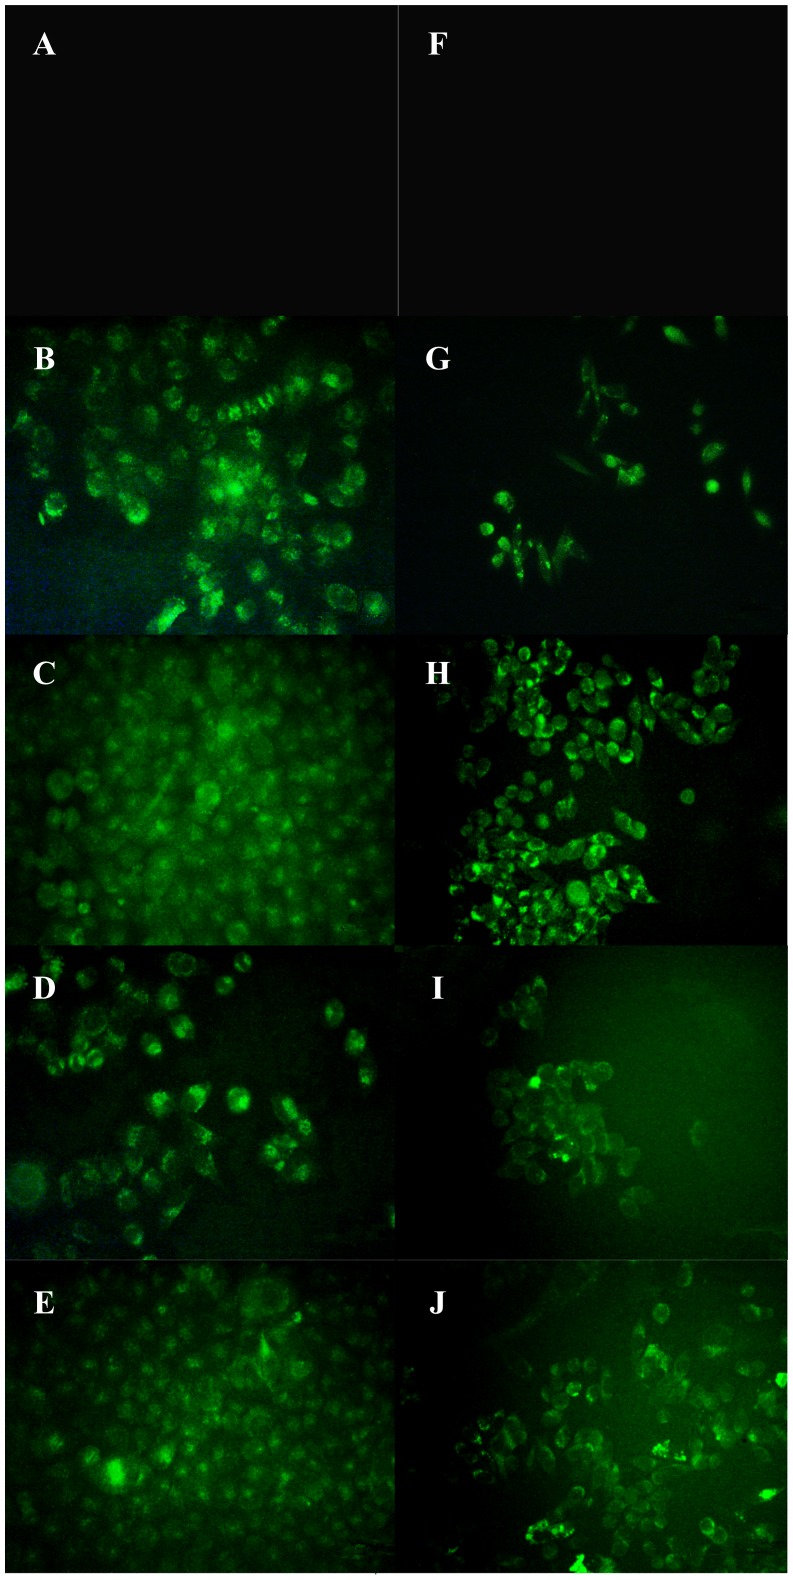
Observation of resveratrol (RES) and piceid (PD) uptake in HepG2 cells (A, B, C, D, E) and MDA-MB-231 cells (F, G, H, I, J) by fluorescence microscopy.Panel A and panel F-negative control; Panel B and panel G-incubating with resveratrol for 5 min; Panel C and panel H -incubating with resveratrol for 15 min; Panel D and panel I -incubating with piceid for 5 min; Panel E and panel J -incubating with piceid for 15 min. The concentration of resveratrol or piceid is 20 µmol/L.